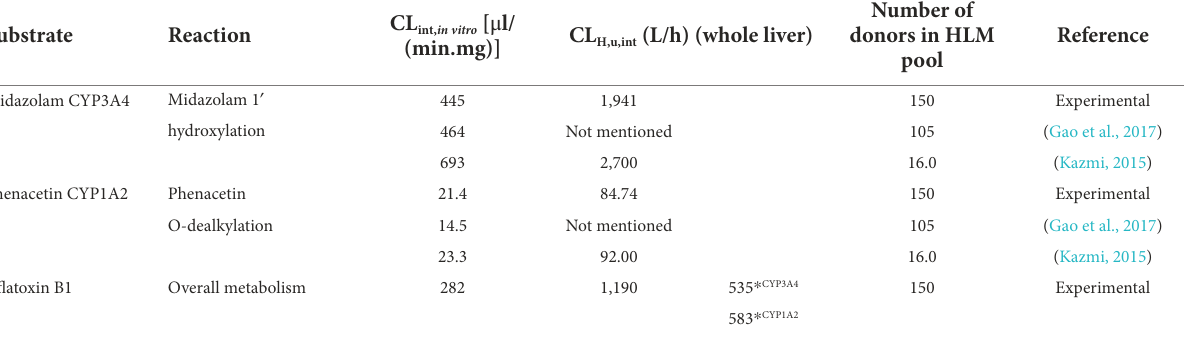
TABLE 4 Overview of intrinsic in vitro clearance and intrinsic in vivo clearance for certain CYP probes and AFB1.